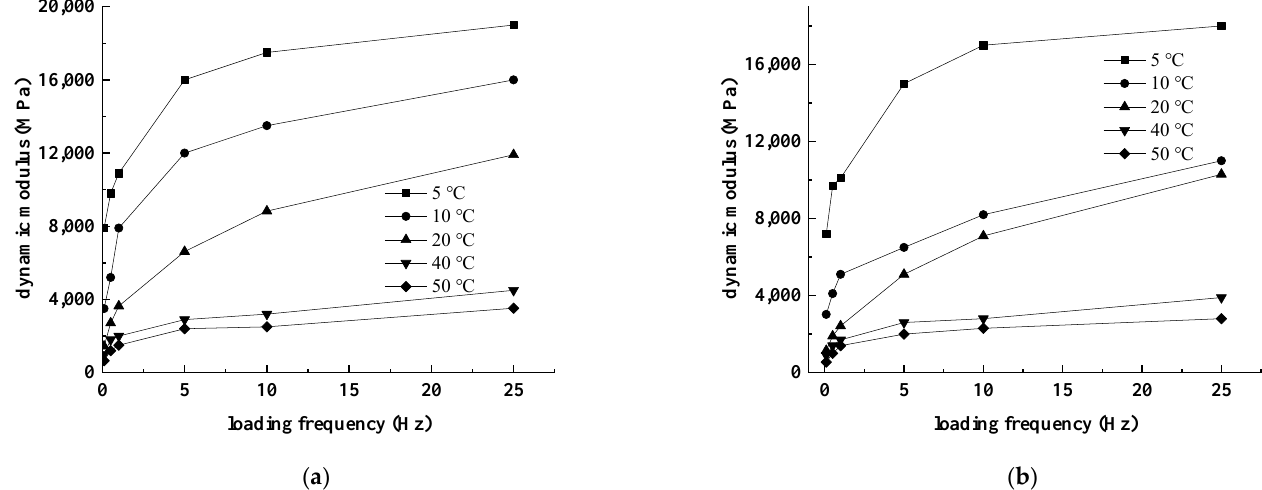
Figure 10. Relationship between the dynamic moduli and loading frequencies of different asphalt mixtures: ( a ) rubber- powder-modified asphalt mixture; ( b ) SBS-modified asphalt mixture.